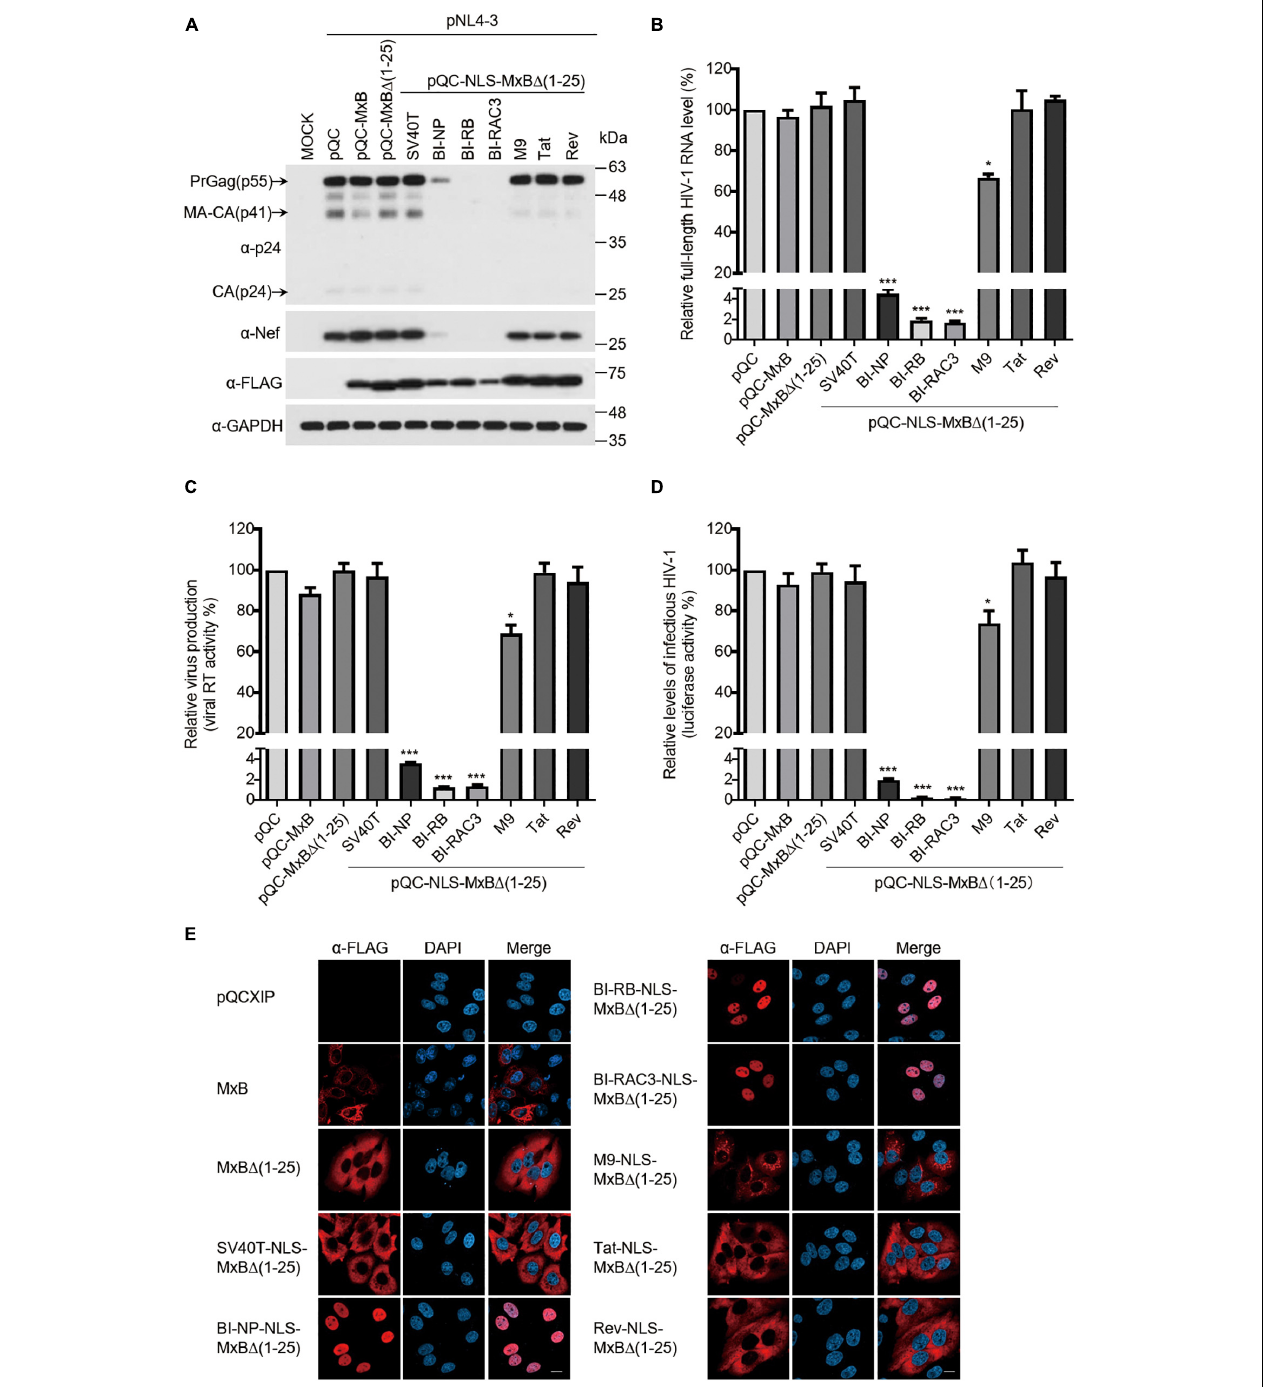
FIGURE 3 | The bipartite NLS-bearing MxB dramatically suppresses HIV-1 gene expression. (A) HEK293T cells were transfected with wild type or mutant MxB DNA bearing a C-terminal Flag tag together with HIV-1 NL4-3 proviral DNA. At 48 h post-transfection, lysates of transfected cells were subjected to Western blotting to examine the levels of Gag/p24, Nef, and MxB. GAPDH was also examined as the internal control. (B) Total RNA was extracted from the above transfected cells. The levels of full-length HIV-1 RNA were determined by RT-qPCR, and the data were normalized to the levels of β -actin mRNA. Data shown are the average from three independent transfection experiments. (C) The levels of viral RT activity in the culture supernatants were determined, the results report the amounts of HIV-1 particles that were produced by the transfected HEK293T cells. Data shown are the average of three independent experiments. (D) The levels of infectious HIV-1 in the culture supernatants were determined by infecting TZM-bl indicator cells using the same volume of supernatants. Data shown are averages from three independent experiments. (E) HeLa cells were transfected with either wild type pQCXIP-MxB or its mutants bearing a C-terminal FLAG tag. The subcellular localization of MxB and its mutants was visualized by immunofluorescence staining and confocal microscopy. Representative images are shown. Scale bars represent 10 µ m.